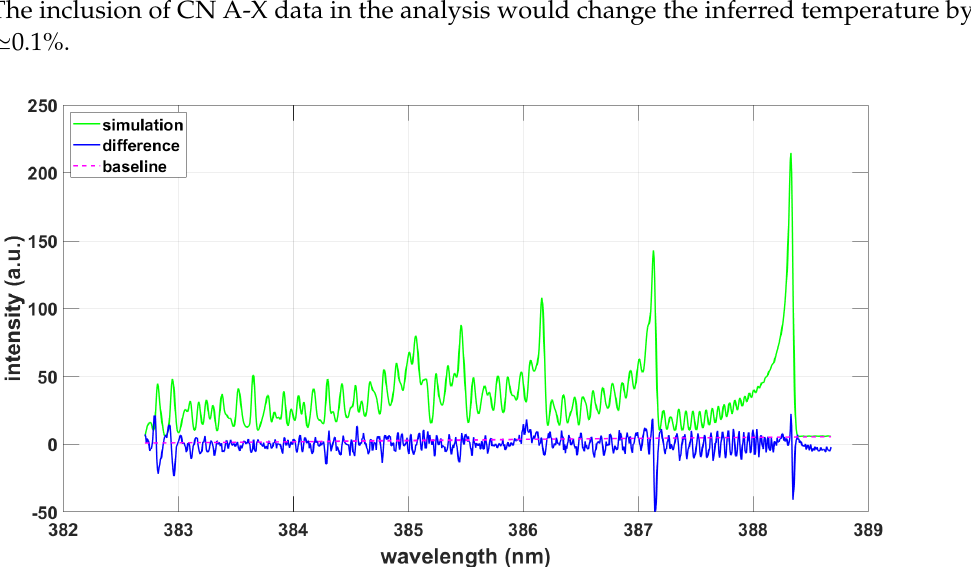
Figure 2. Simulation using PGOPHER data and the NMT program, T = 8240 K, ∆ λ = 0.034 nm.